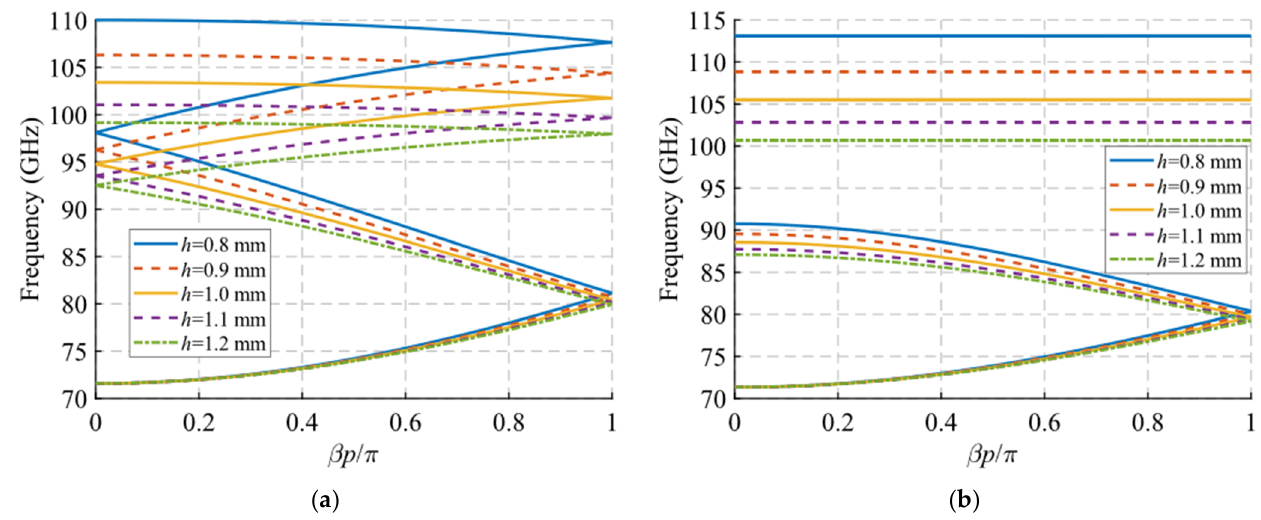
Figure 7. Dispersion diagram of the double-periodic unit cell for various values of h . ( a ) Glide-symmetric configuration ( d = 0.725 mm) and ( b ) maximum rupture of symmetry configuration ( d = 0 mm).